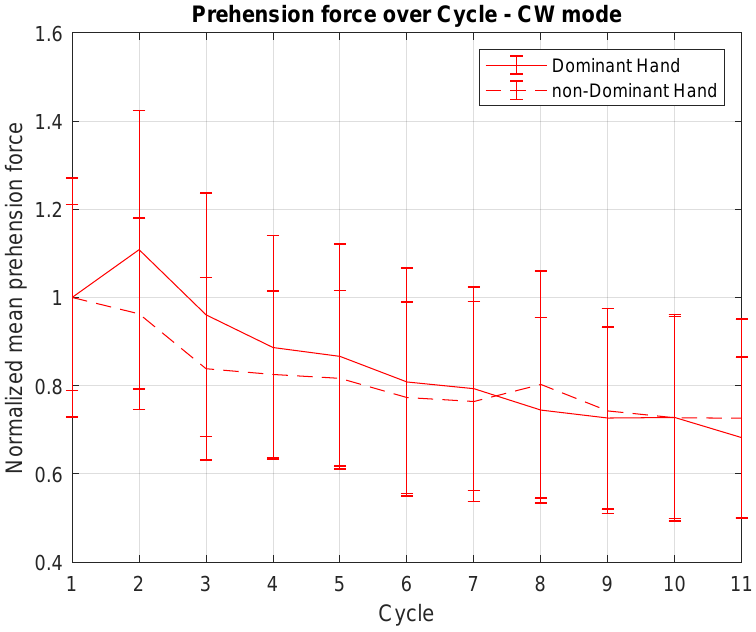
Figure 12. Mean prehension force, over cycles, for dominant and non-dominant hands, only for CW task. Normalisation was carried out based on the mean value of the first cycle, for each